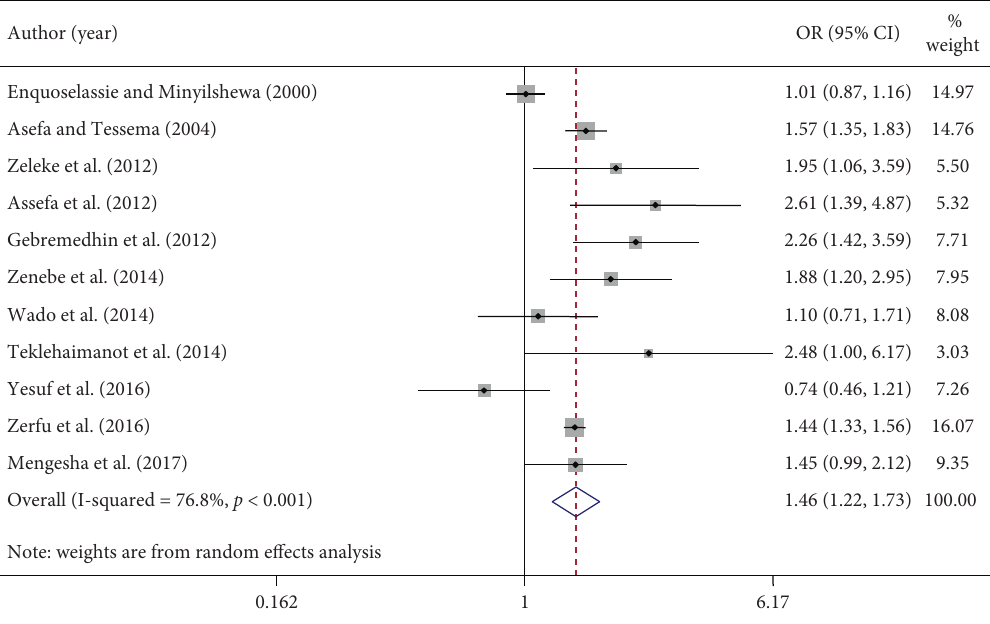
Figure 3: Forest plot displaying the association of sex of the newborn and low birth weight in